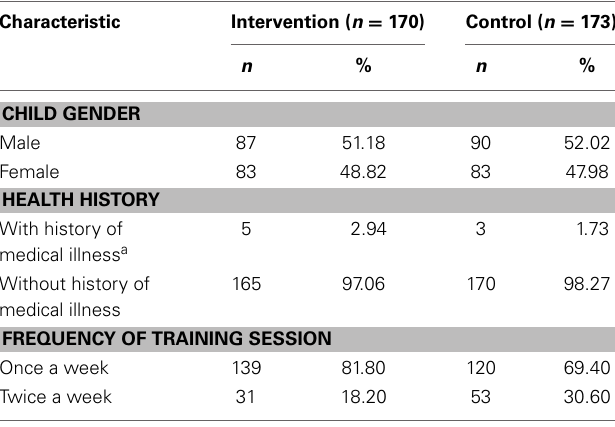
Table 3 | Sociodemographic information of the SIP sample by group (categorical